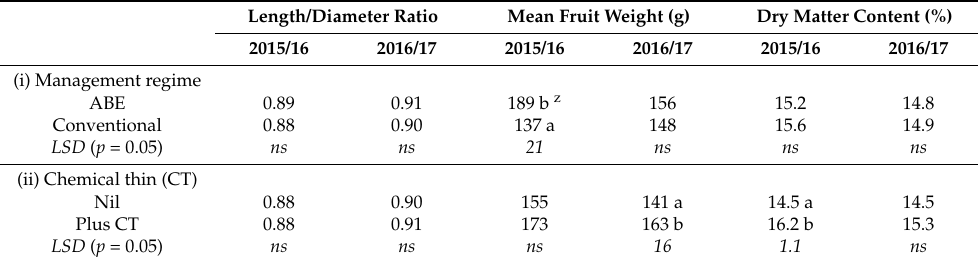
Table 11. Effect of management regime and thinning method on fruit shape, weight and dry matter content of ‘Fiero Fuji’ (Trial 3). ABE = artificial bud extinction.